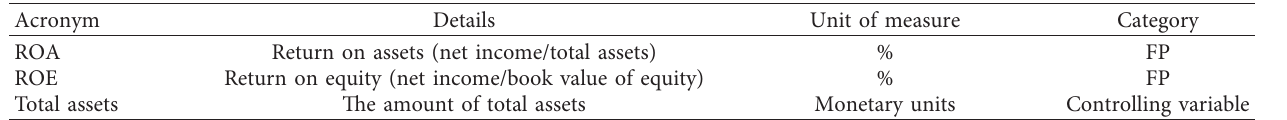
Table 2: Dependents variables included within the econometric